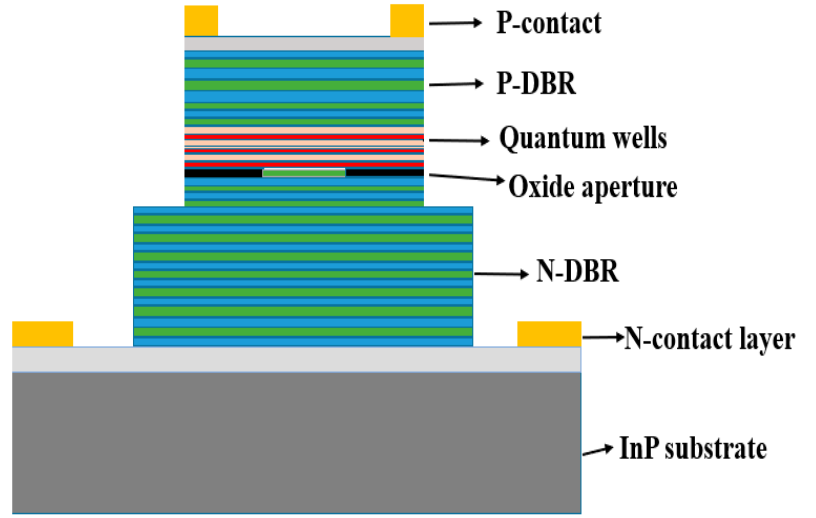
Figure 1. Schematic of the 1310 nm VCSEL device.